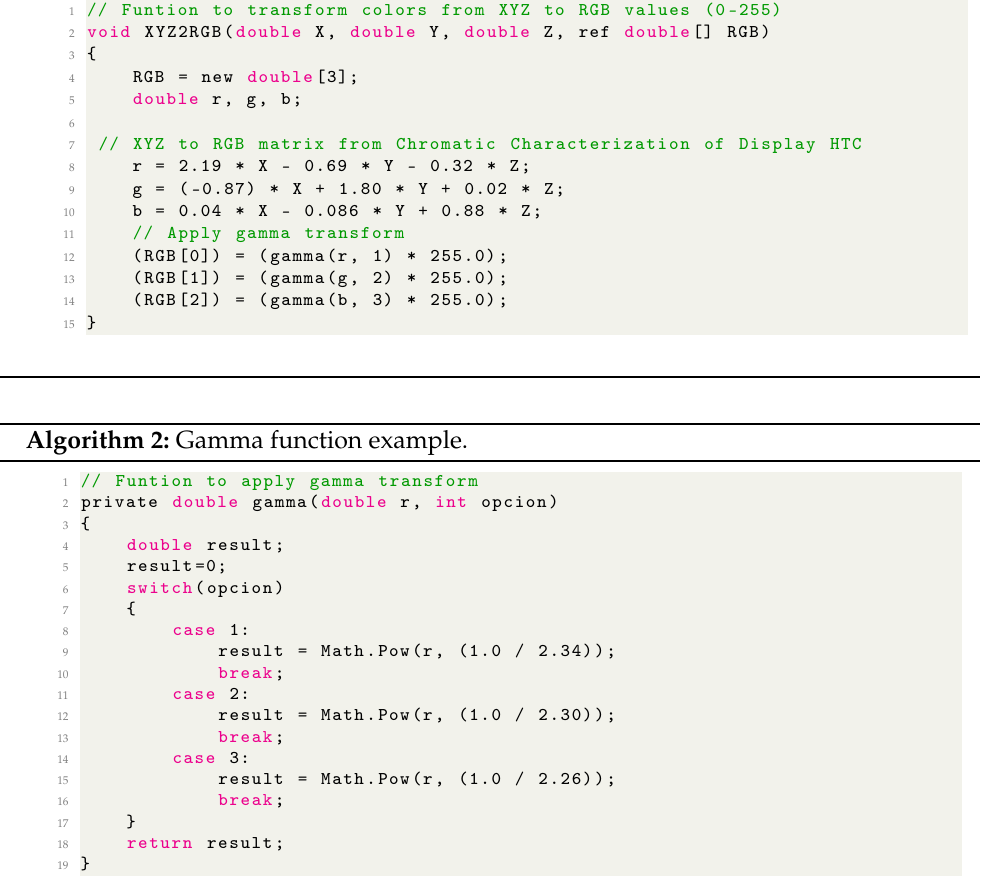
Algorithm 1: Algorithm transformation from XYZ values to RGB.